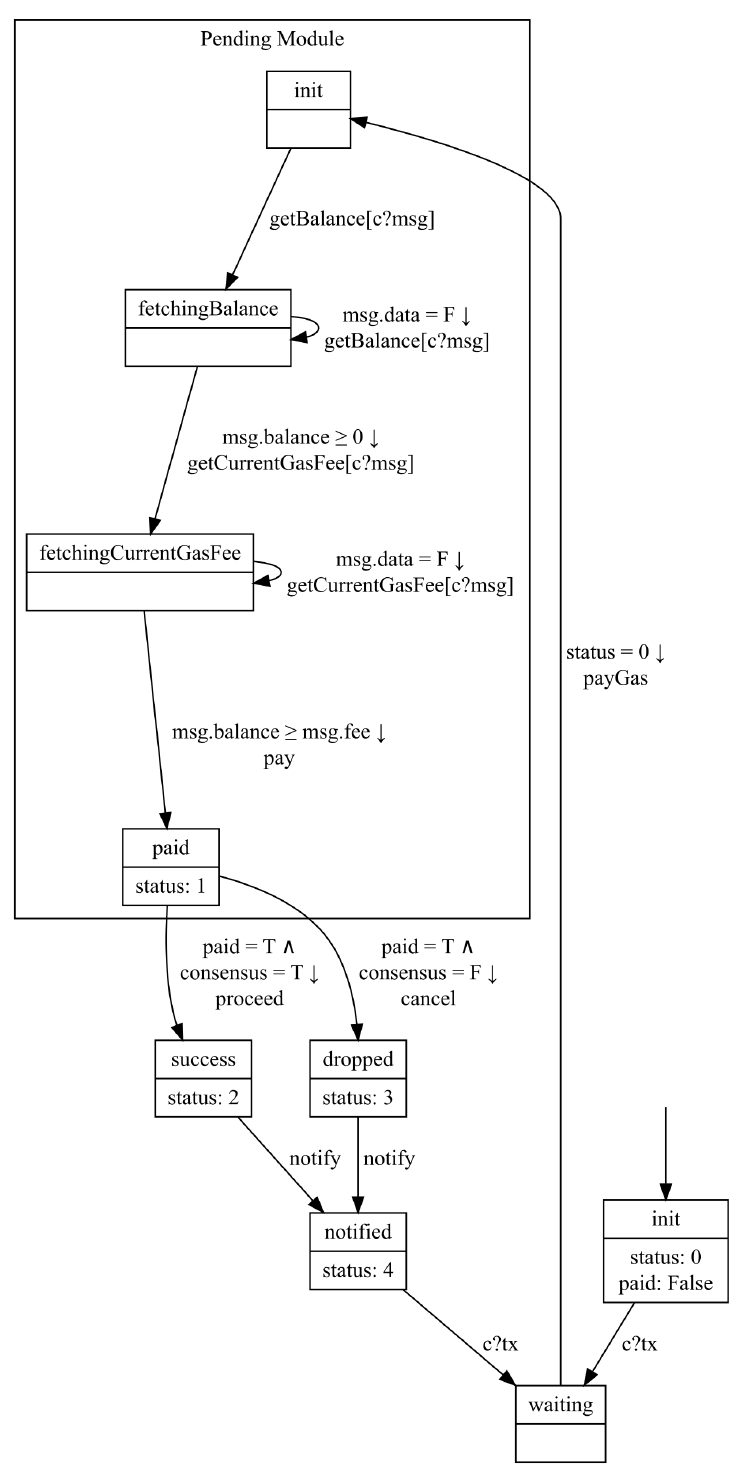
Figure 5. Visualized system graph of the transaction client with the unfold pending module in Example